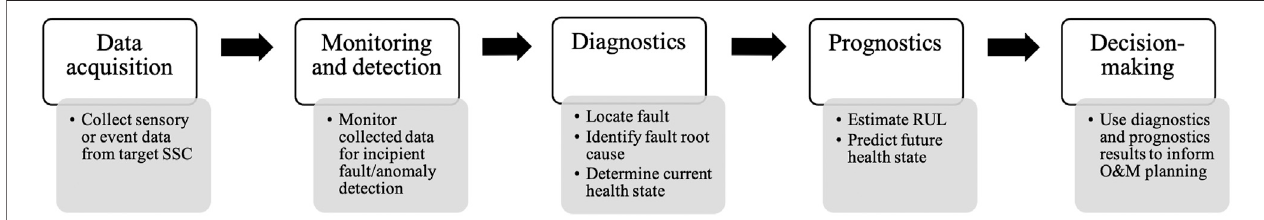
FIGURE 2 | Five modules/steps of PHM [adapted and extended from Coble et al., 2015)].